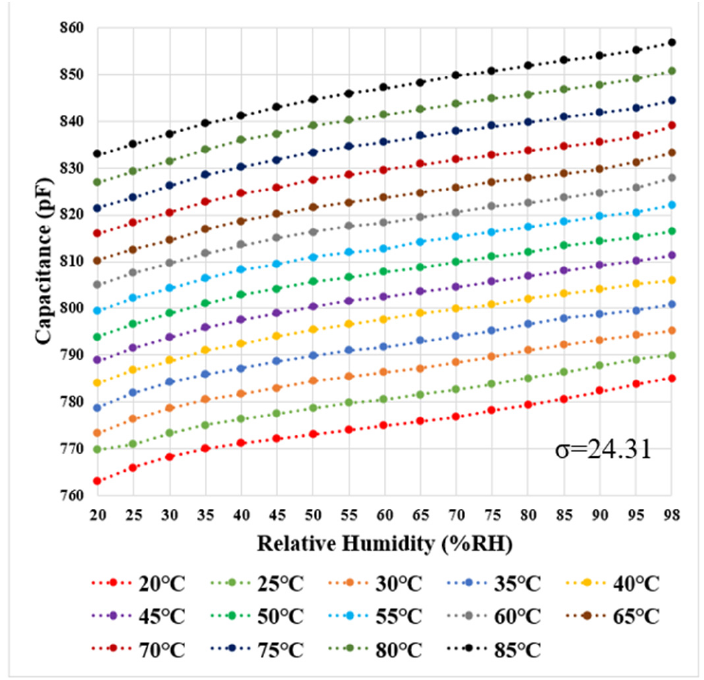
Figure 5. Average calibration curve of the micro humidity sensor (original capacitance value). The stable and variable flow input provided by the 850E Fuel Cell Test System was applied to the calibration of the microflow sensor (see Figures 6 and 7).